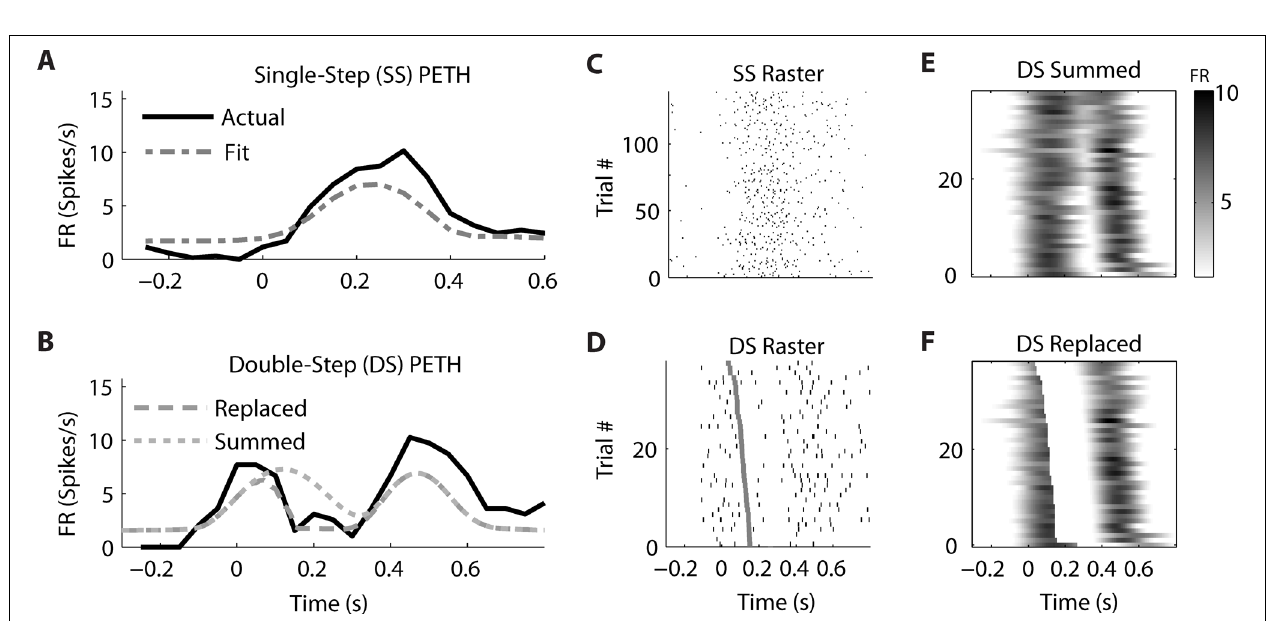
FIGURE 7 |A neuron from primary motor cortex is better fit by the “Replaced” hypothesis. Format follows Figure 5 .